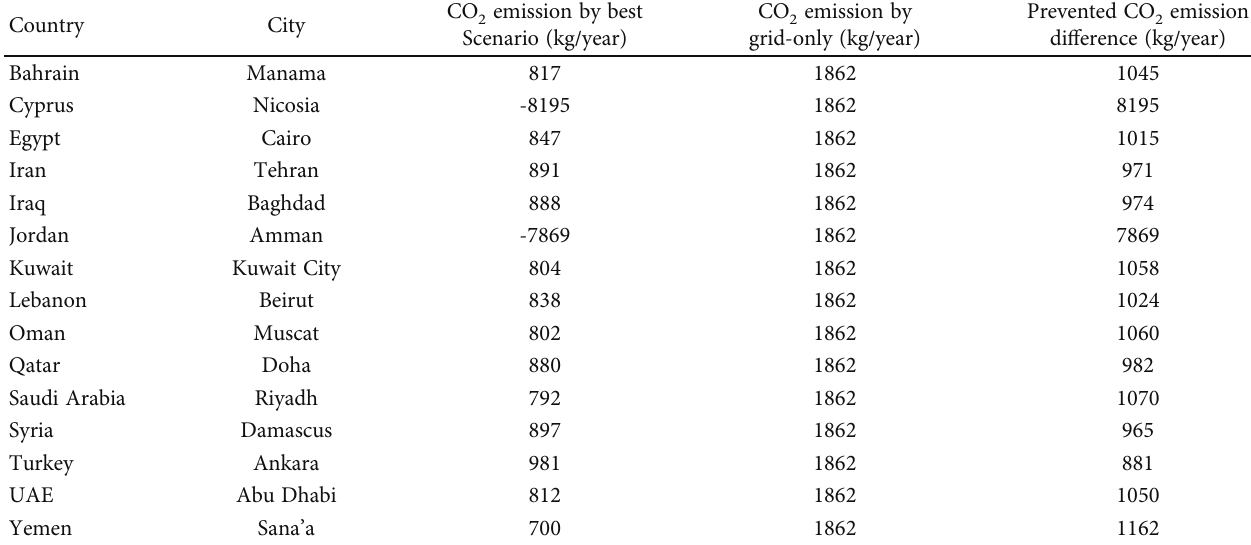
Table 7: Results of environmental